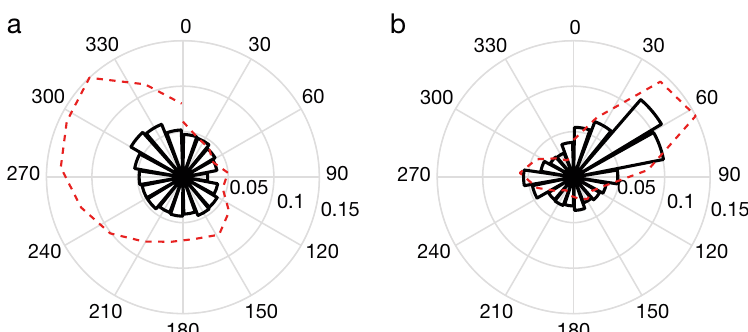
Fig. 3. Current roses showing average current speed and direction measured in the 3rd cell starting at 4 m depth of the DCP at (a) Soløya and (b) Fornes for the entire period the DCP was deployed. North is 0°, and east is 90°. Directions were sorted into bins of 20°, and average current speed for the given bin is shown in the polarplot. The red dashed line shows the direction that had the largest number of measurements, which was normalized based on the direction that had the largest number of measurements